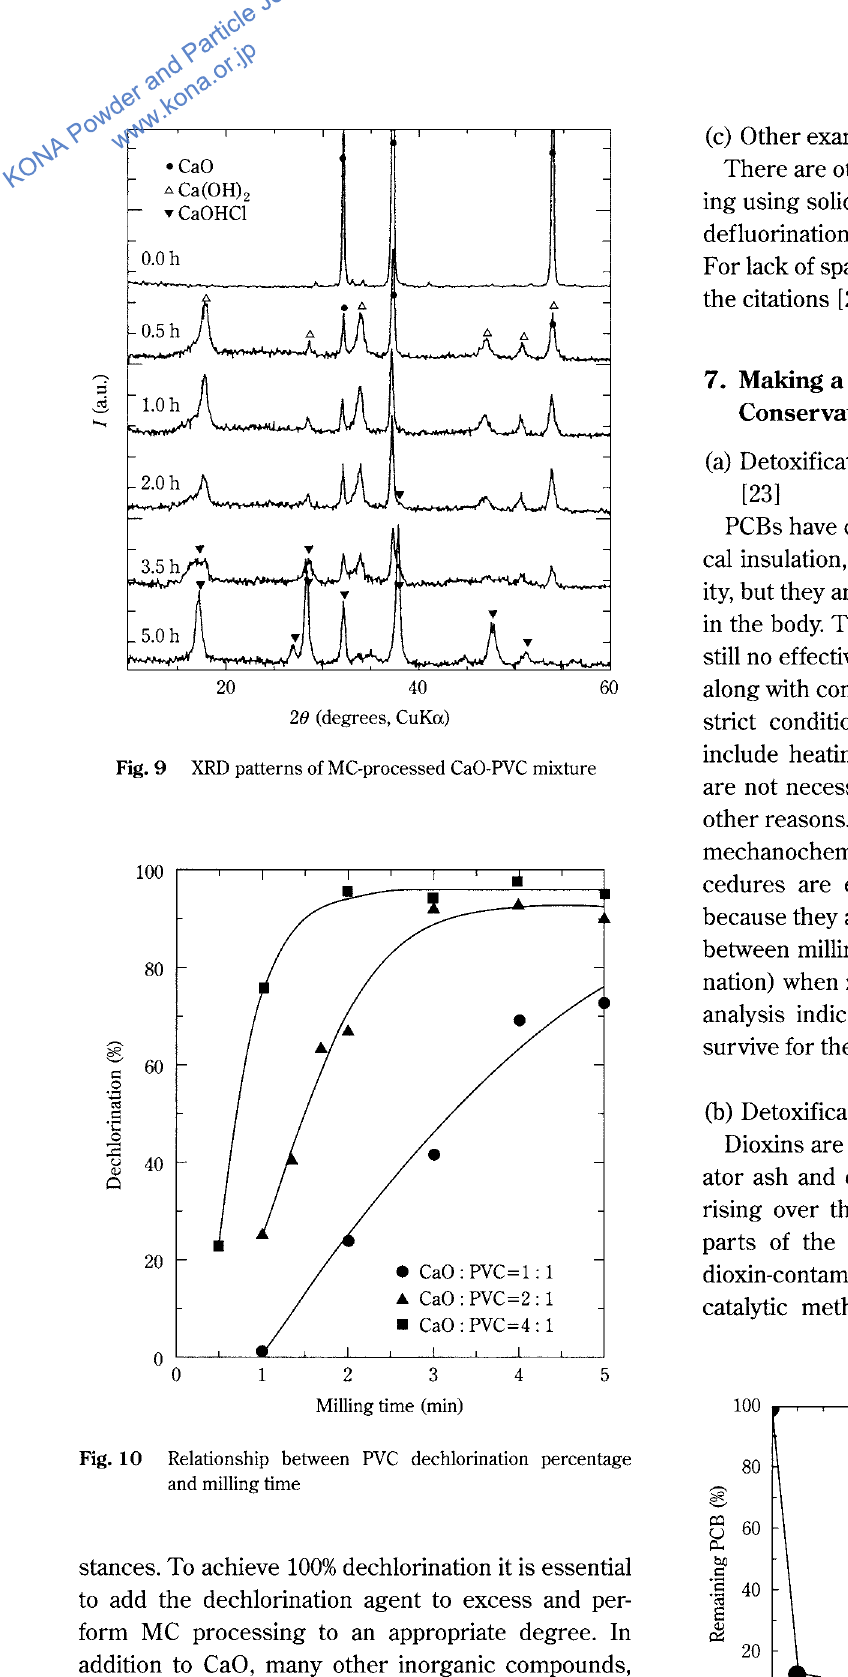
stances. To achieve 100% dechlorination it is essential to add the dechlorination agent to excess and per form MC processing to an appropriate degree. In addition to CaO, many other inorganic compounds, steel slag, and the like can be used as dechlorination agents. The dechlorination percentage can be esti mated from the ball collision energy determined by a ball mill simulation. Relationship between milling time and remaining